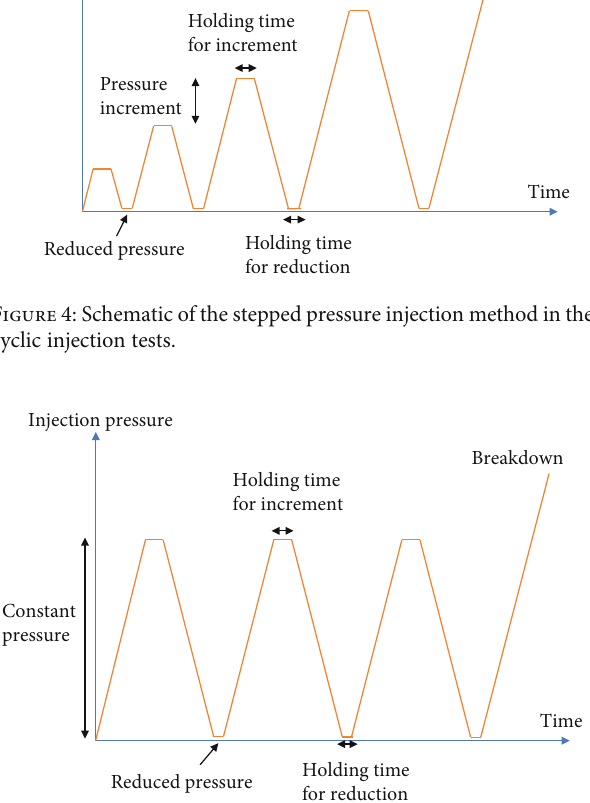
Figure 5: Schematic of the constant pressure injection method in the cyclic injection tests.